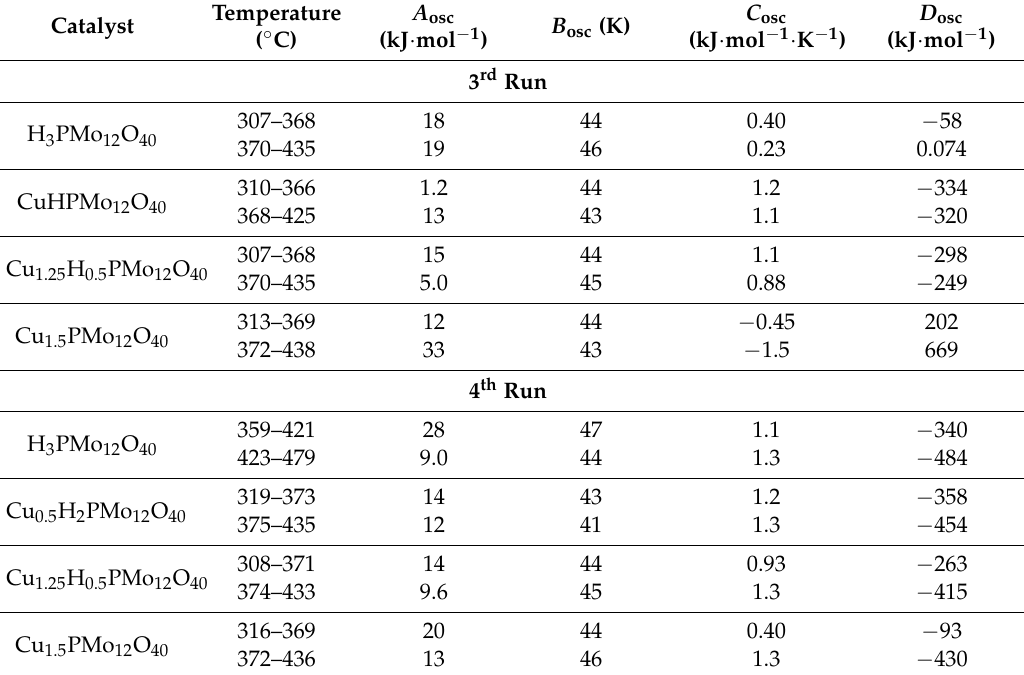
Table 4. Oscillation parameters from Equation (18) fitted to flexible least square activation energies for the selective oxidation of isobutane to methacrolein over the [PMo 12 O 40 ] 3 −